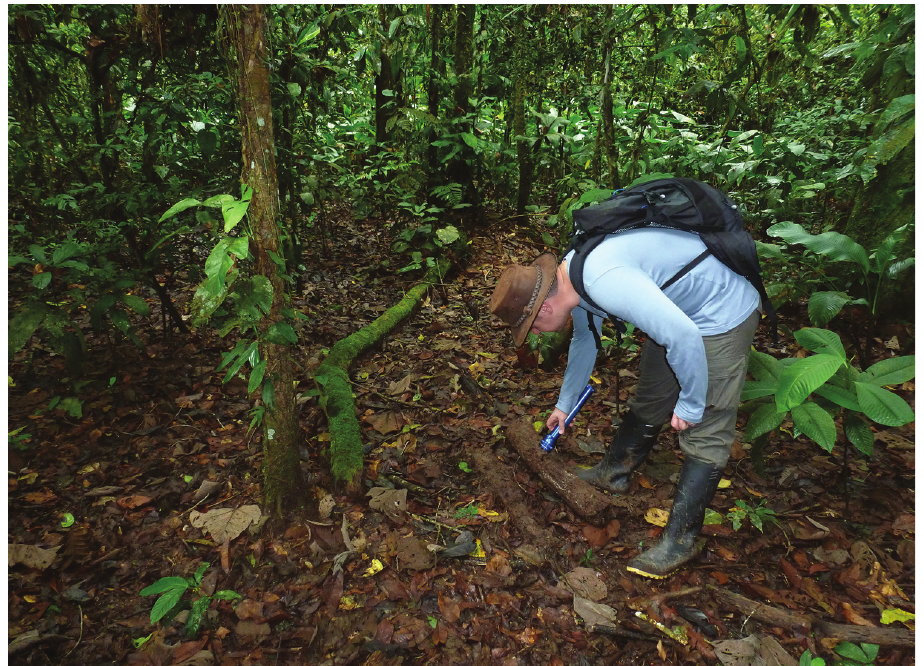
Figure 9. Amazon region, Ecuador. Natural habitat of Teuthraustes khodayarii sp. n. and Teuthraustes giupponii sp. n. (photograph C. Benros-Ythier; E. Ythier in the